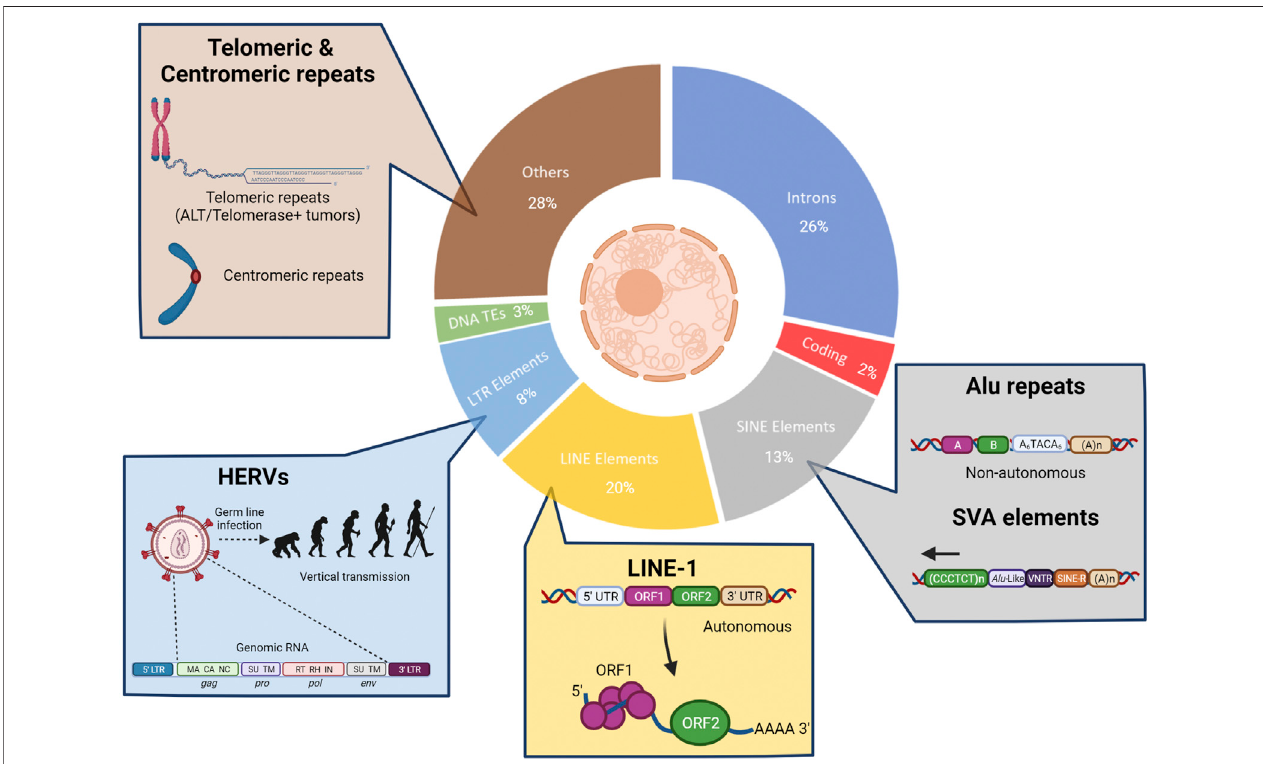
FIGURE2 | Theunder-explored parts ofthe human genome.Most cancerresistance mechanism studies have focused on the non-repetitive protein-coding parts of the human genome (2%, red). However, a large part of the human genome consists of non-coding sequences that comprise the intergenic DNA, centromeric and telomeric repeats (light brown) as well as integrated viruses and transposable elements (TEs) that have been replicated in the human genome during evolution (nearly 50% of the genome). The non-LTR TEs represent almost one-third of the human genome and include non-autonomous Short Interspersed Nuclear Elements (SINEs;grey)andautonomousLongInterspersedNuclearElements(LINEs;yellow).LTRTEsincludehumanendogenousretroviruses(HERVs,lightblue).Therearealso remnants of DNA transposons (green).